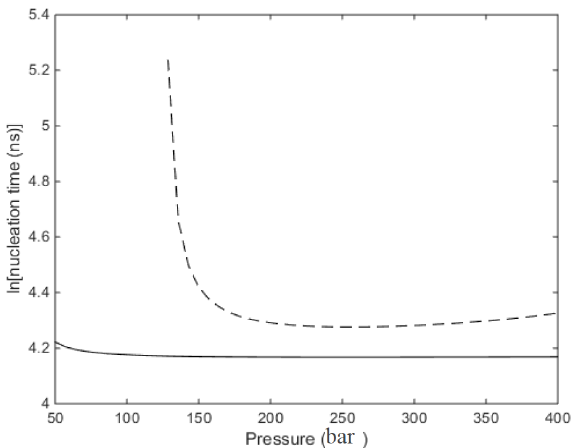
Figure 12. Calculated nucleation times for heterogeneous hydrate formation from CO 2 and liquid water. Solid curve is for 280 K, and dashed curve is for 285 K.